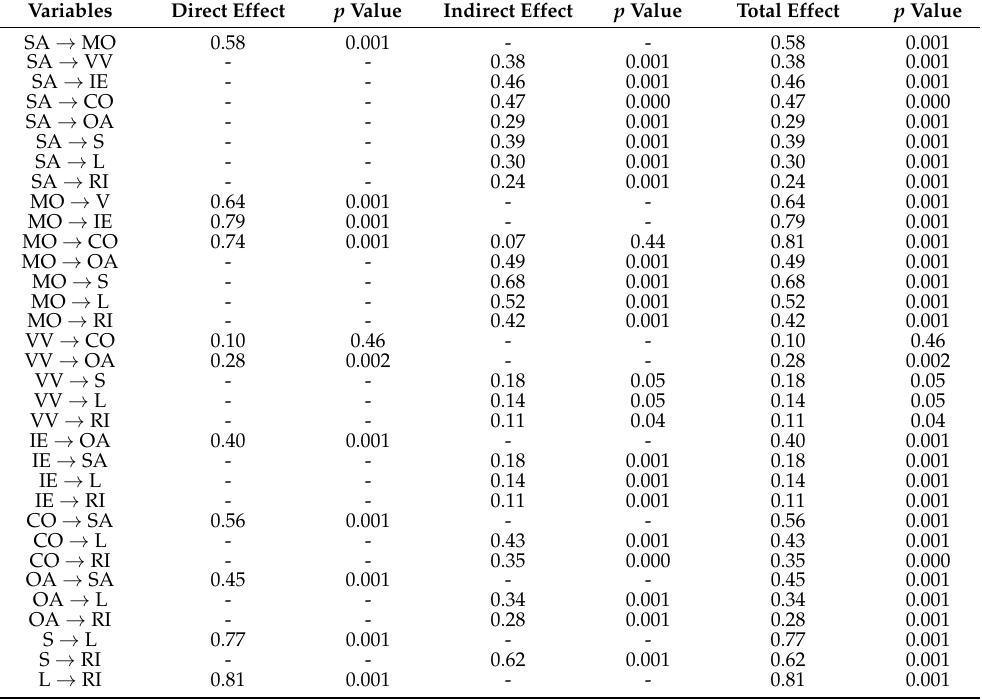
Table 6. Direct effect, indirect effect, and total effects. “-” means “no